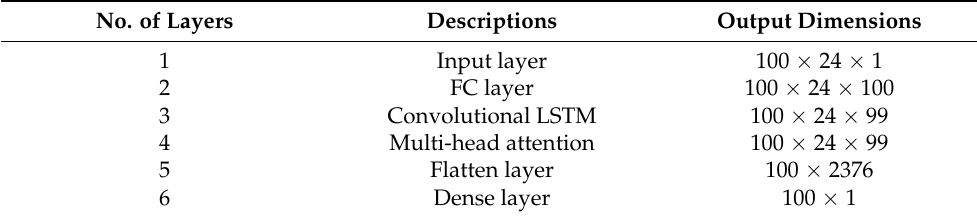
Table 2. The model architecture and hyperparameters used for the next 1st-hour traffic flow predic- tion task.